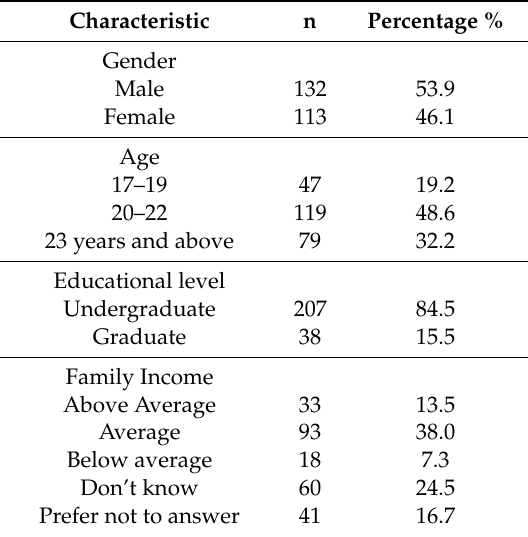
Table 1. Participants’ demographic